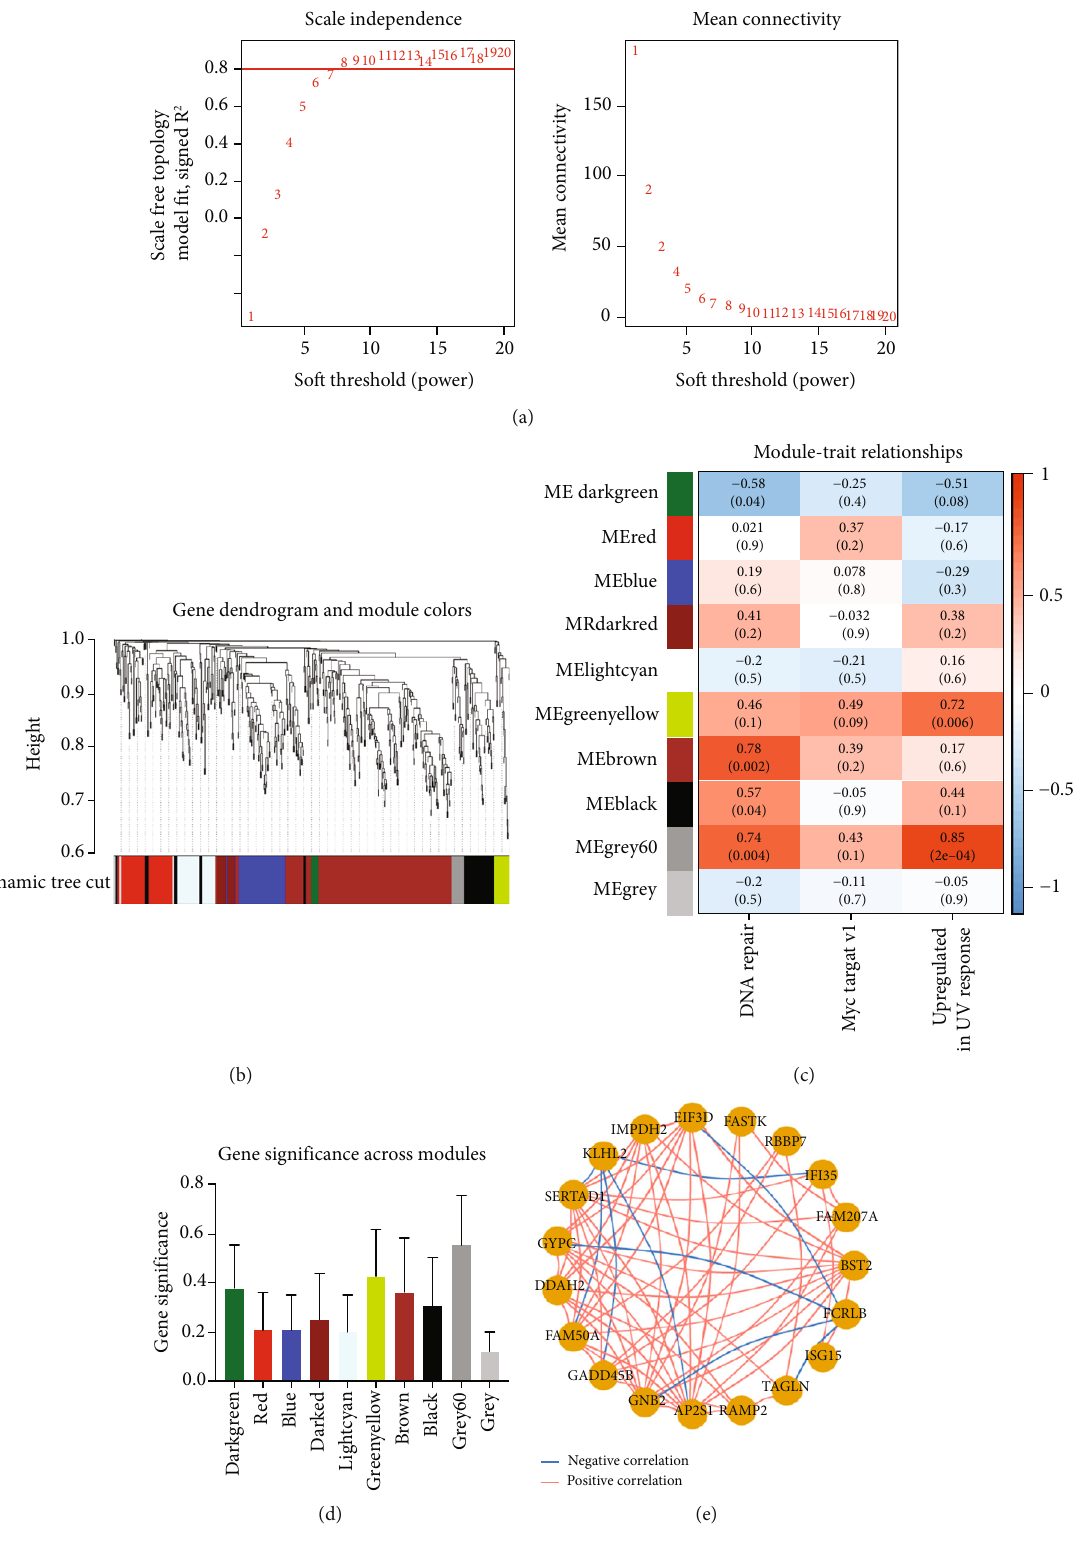
Figure 4: Identi fi cation of the key module by WGCNA. (a) Analysis of the scale-free fi t index (left) and the mean connectivity (right) for various soft-thresholding power values. (b) Clustering dendrogram of DEGs with assigned module colors. (c) Heat map of the correlation between modules and hallmark activities of BKVN. Each cell contains the Pearson correlation coe ffi cient and P value. (d) Histogram of the gene signi fi cance across modules for three hallmarks in BKVN. (e) Correlations of the expression levels of 19 genes that belong to grey60 module. Blue curves indicate negative correlations, and red curves indicate positive